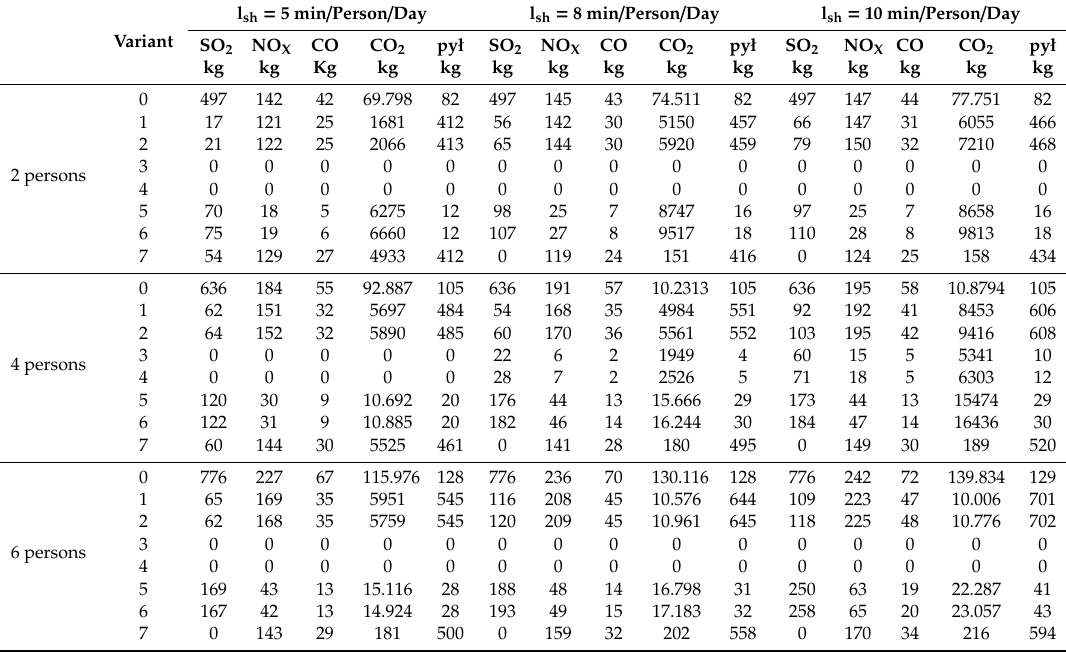
Table 8. Emission of pollutants over a period of 25 years.